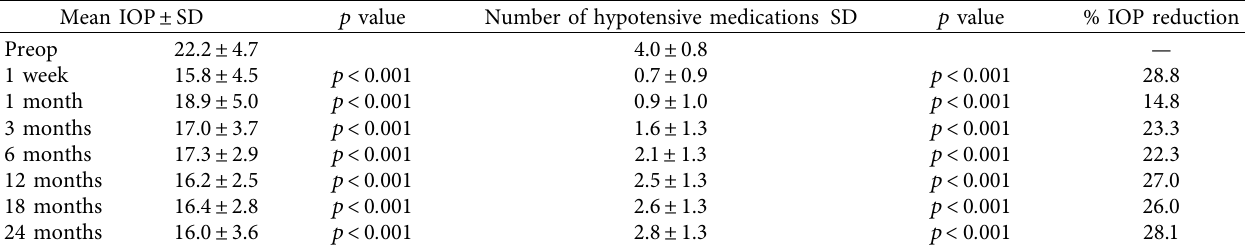
Table 3: Intraocular pressure and number of hypotensive medications after UCP—24-month follow-up